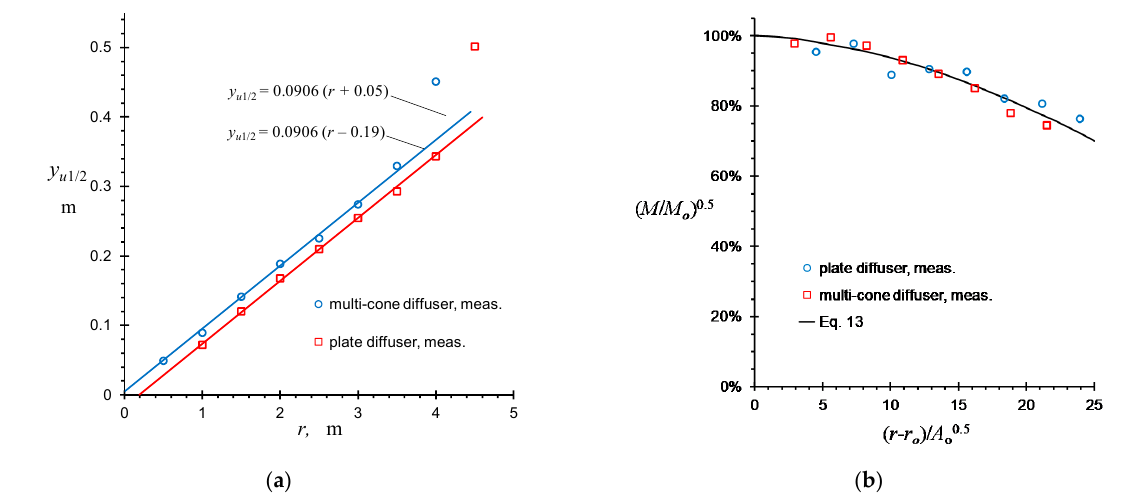
Figure 8. Results of measurements in tested RWJs at the airflow rate 793 m 3 /h. ( a ) The growth of the half-width of RWJs with the distance from the diffuser, ( b ) the decrease of momentum flux with the distance from the diffuser. Table 3. The gross and integral parameters of the tested RWJs from multi-cone and plate diffusers. Multi-Cone Diffuser Plate Diffuser